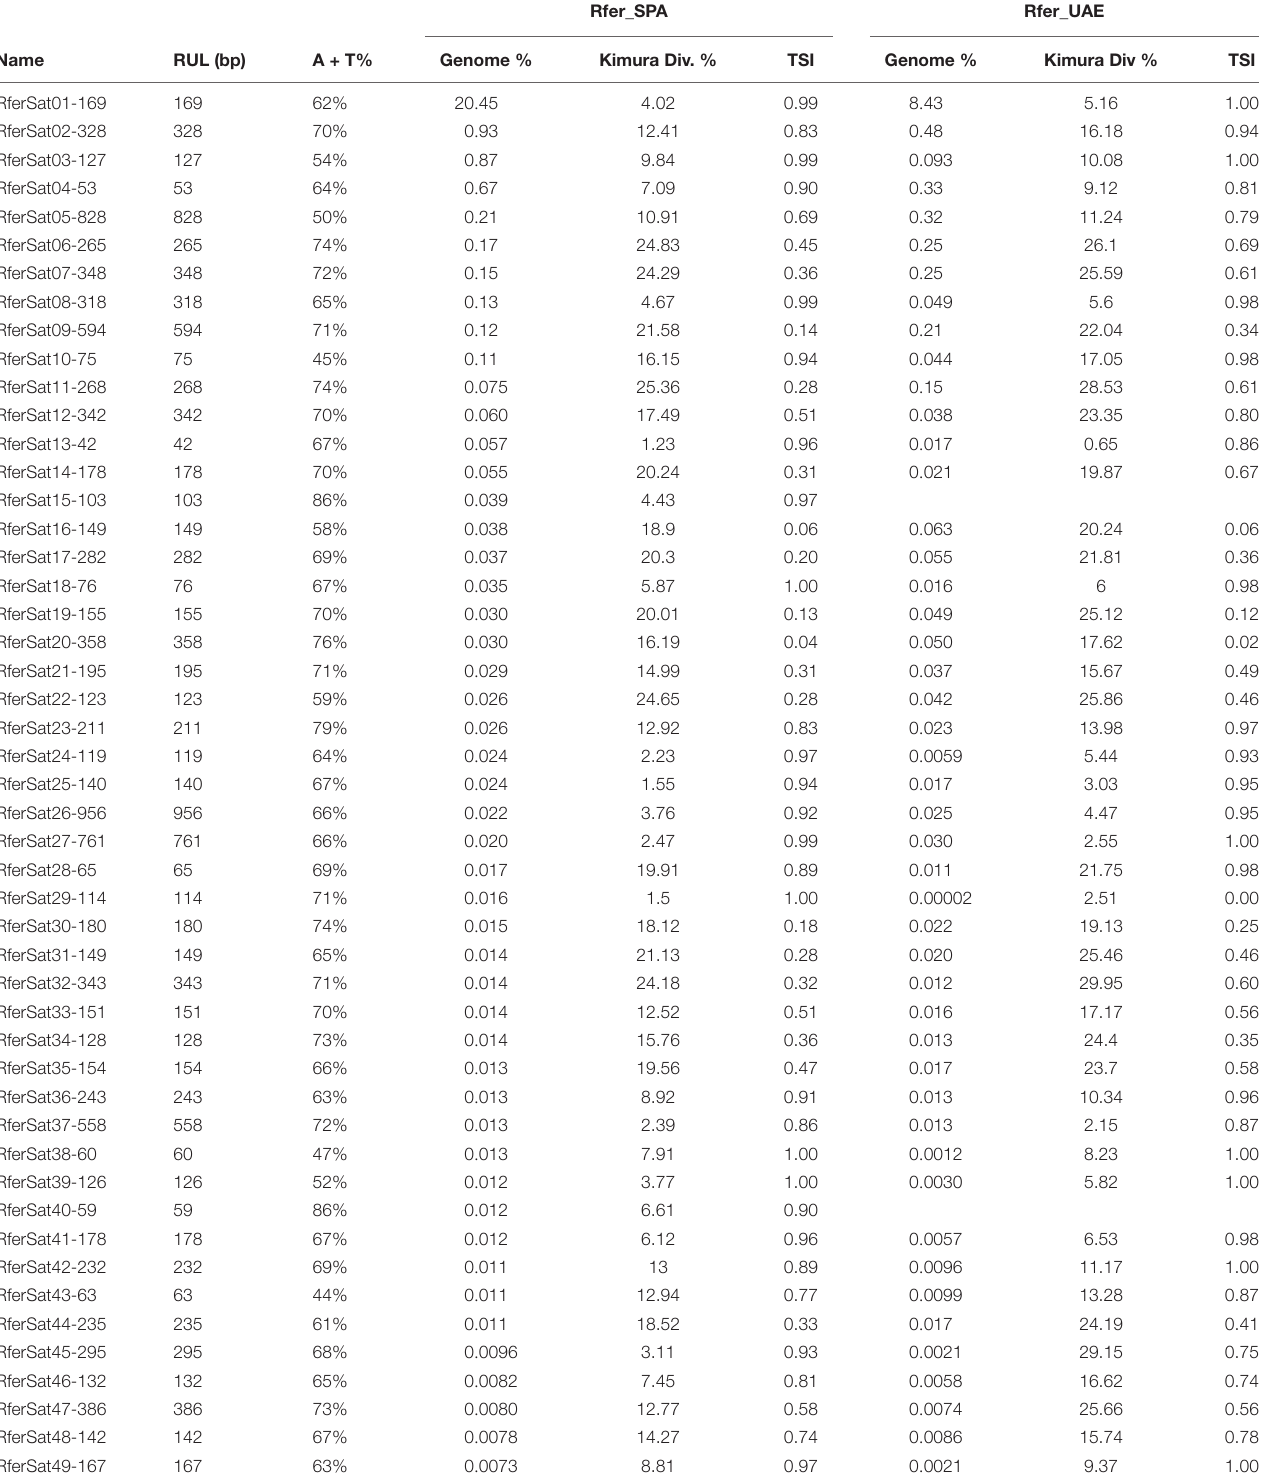
TABLE 1 | Data of the satDNA families found in Rhynchophorus ferrugineus populations: repeat unit length (RUL), A + T content, genome abundance (%), divergence (%) and tandem structure index (TSI). Rfer_SPA